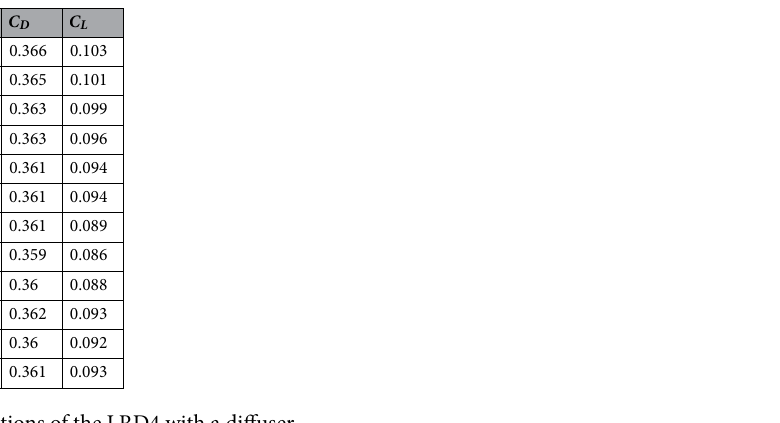
Table 5. Many configurations of the LRD4 with a